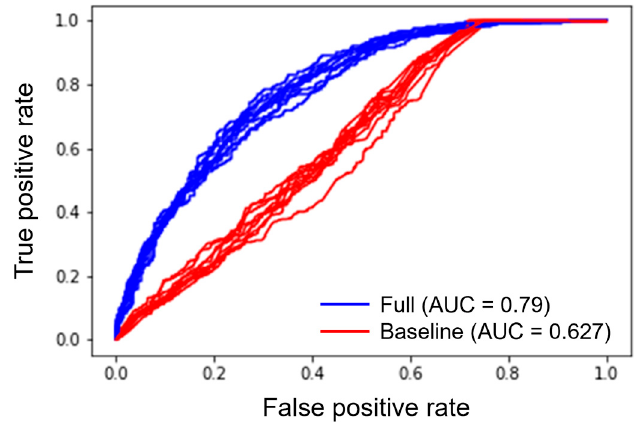
Figure 2. Ten iterations of a training-test split following which the longitudinal remission model is used to classify whether a patient will be in remission at a given week that was not observed in the training data. The full model makes use of all 22 variables (including non-significant ones), whereas the baseline model only uses time.